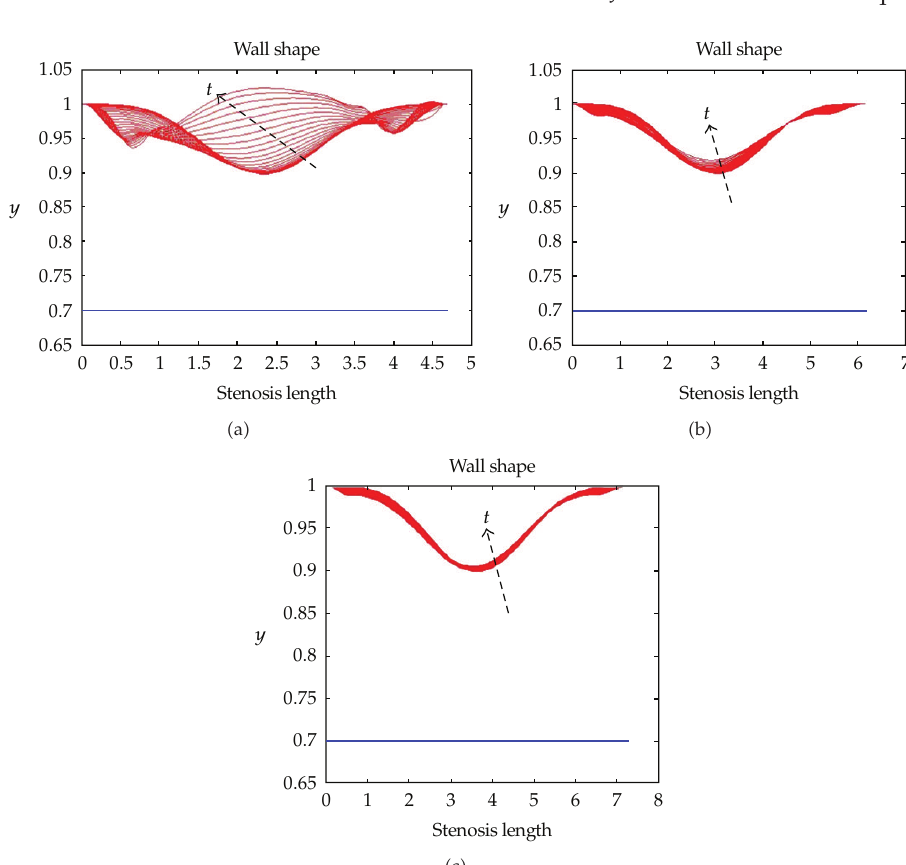
Figure 6: Wall shape for inlet velocity U o of 0.1m/s (cid:3) a (cid:4) , 0.2m/s (cid:3) b (cid:4) , 0.3m/s (cid:3) c (cid:4) .